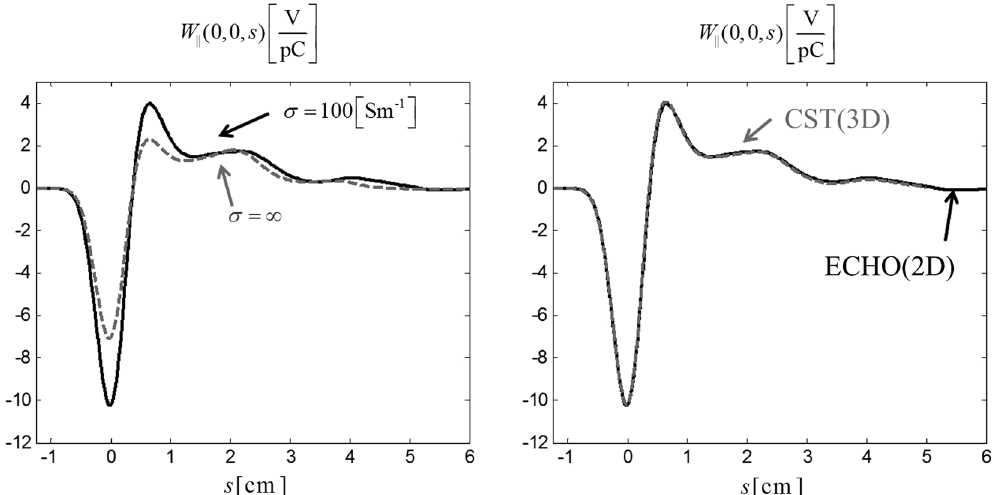
FIG. 10. Longitudinal wake potential of tapered collimator.